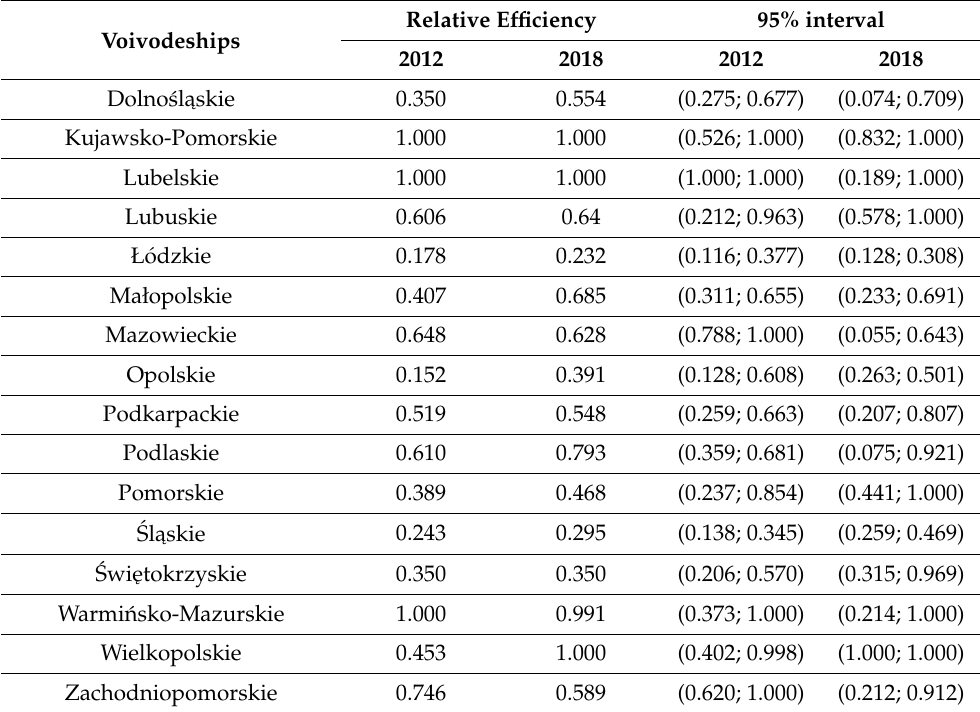
Table 4. Relative efficiency of voivodeships in the production of heat from biogas and biomass including a sensitivity analysis in 2012 and